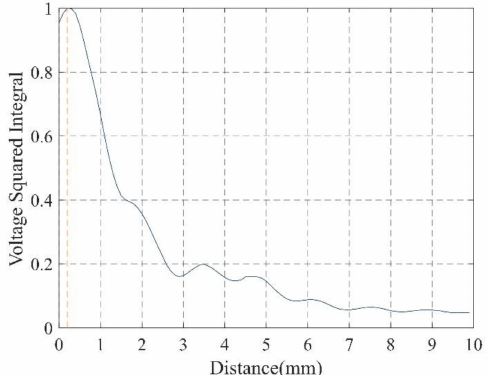
Figure 7. The relation between voltage squared integral and